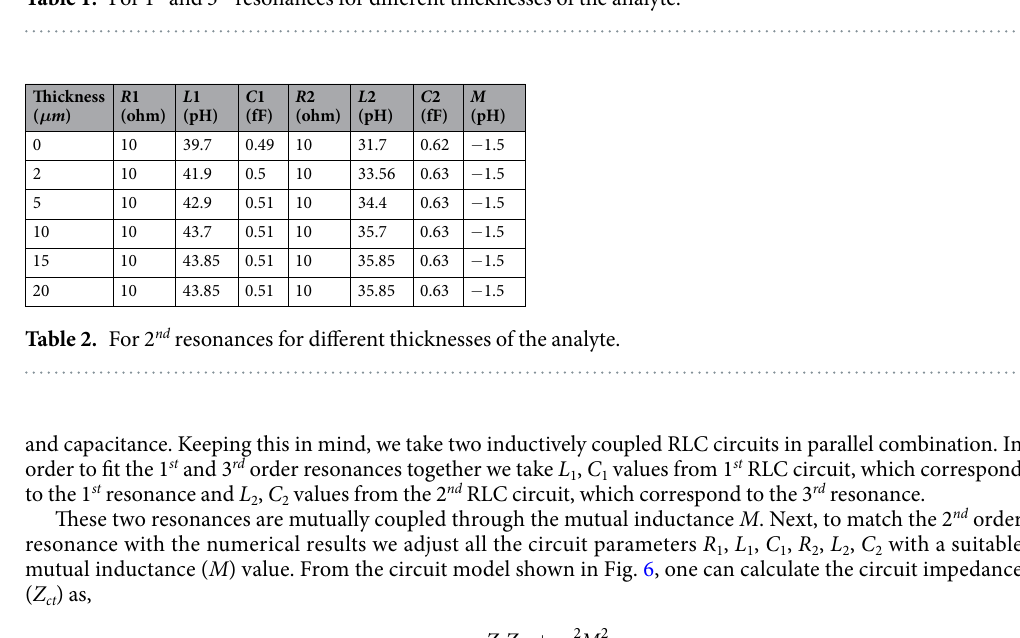
Table 1. For 1 st and 3 rd resonances for different thicknesses of the analyte.